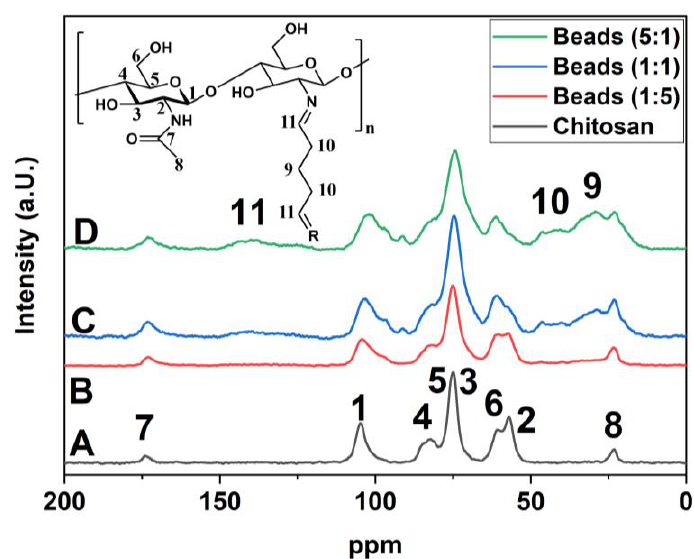
Figure 2. Solids 13 C CP-MAS NMR spectra at 125 MHz: chitosan (no calcium) (A), calcium imbibed beads cross-linked at variable cross-linking (CL) ratios of glutaraldehyde to chitosan monomer units of 1:5 (B), 1:1 (C) and 5:1 (D).